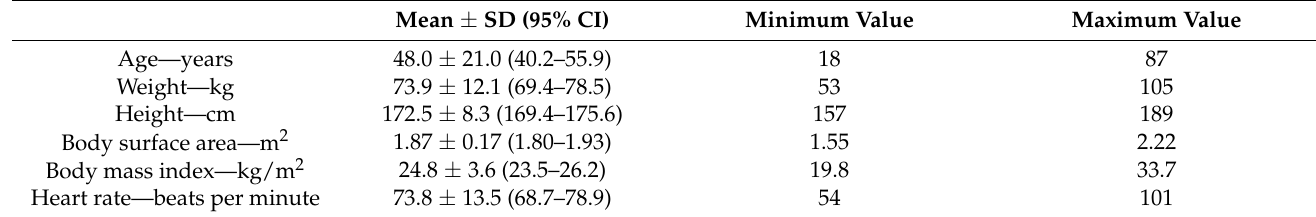
Table 3. Study population